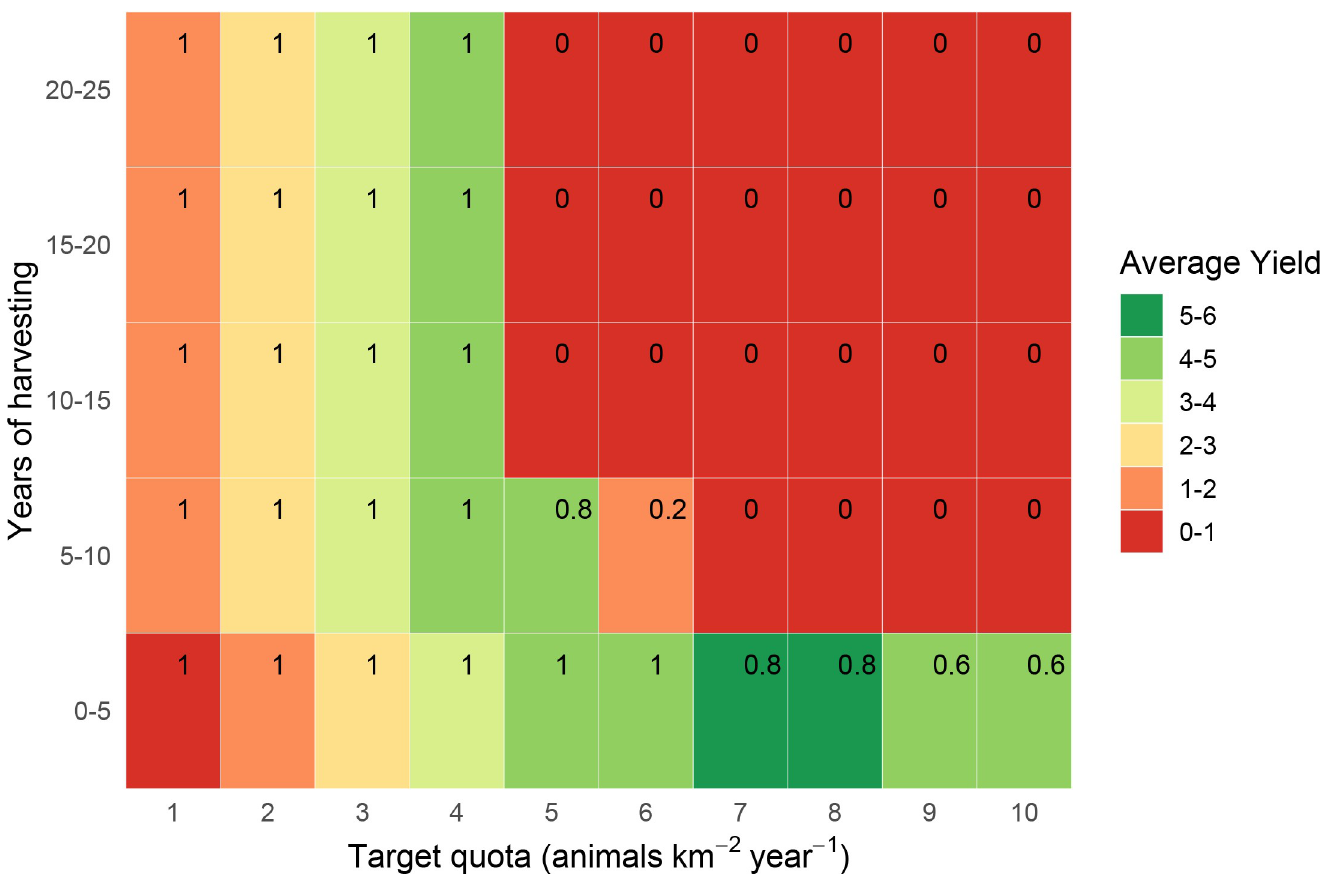
Fig 5. Estimated yields (animals km -2 year -1 ) from quota-based harvesting of blue duiker C . monticola . Yields are estimated over 25 years in 5-year increments, without parameter uncertainty, with corresponding survival probabilities (in top-right corner of each rectangle).